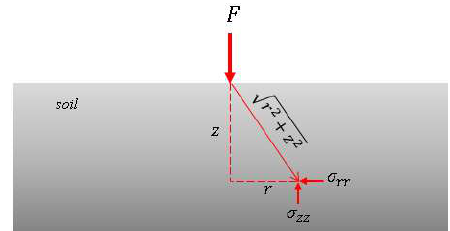
Fig. 1. Sketch of a single point-force applied at the top of a granular bed. We define the reference system and the vertical stress 𝝈 𝒛𝒛 = 𝑷(𝒓,𝒛) , according to Eq.